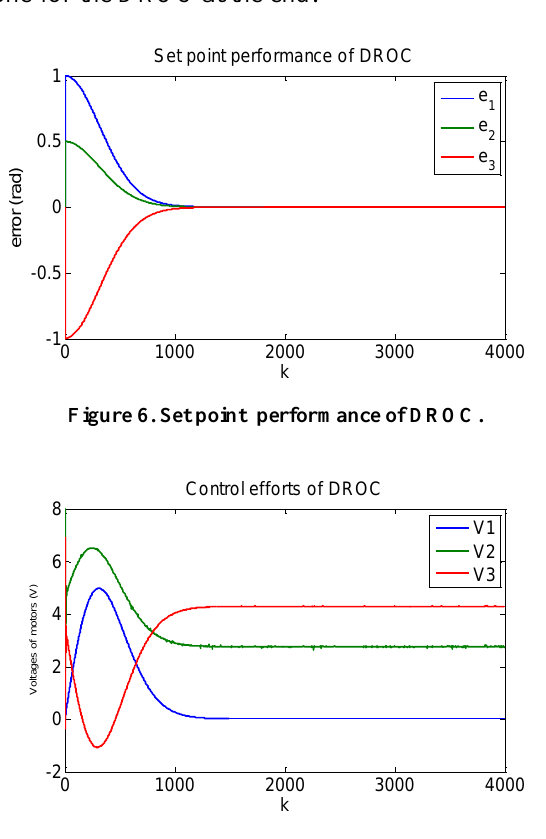
Figure 7. Control efforts of Set point DROC.